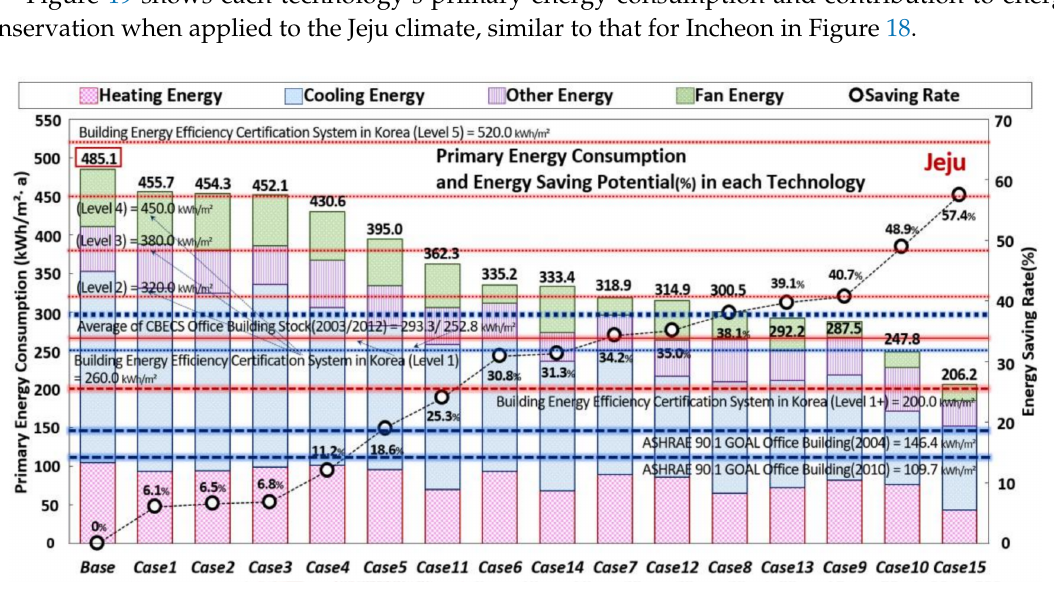
Figure 19. Primary energy consumptions and energy saving potential in each technology